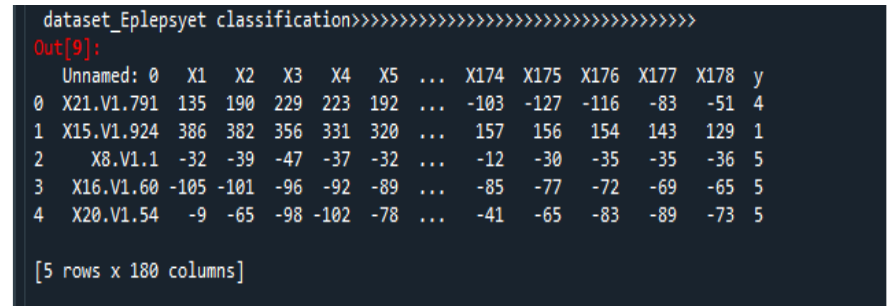
Figure 2. Randomly Sample View of Epileptic Recognition Dataset.